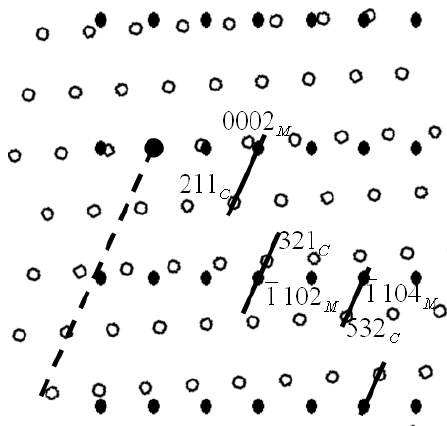
Figure 7. Simulated diffraction patterns of the Mg matrix and CaMgSn along the zone axis [101(cid:4636)0] /[111] Mg / CaMgSn showing a set of parallel ∆ gs . The dashed line indicates the habit plane where the superscript “ C ” denotes CaMgSn and the superscript “ M ” denotes Mg.